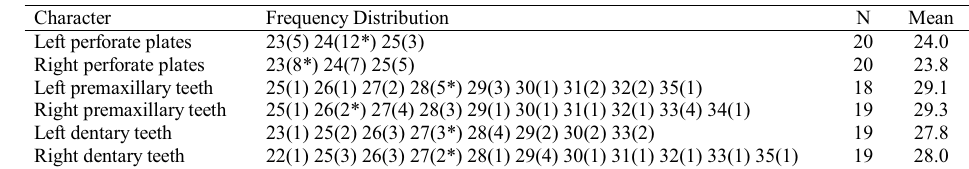
Table 2. Frequency distribution for meristics of Gymnotocinclus anosteos . Holotype values are marked with an asterisk. N = number of